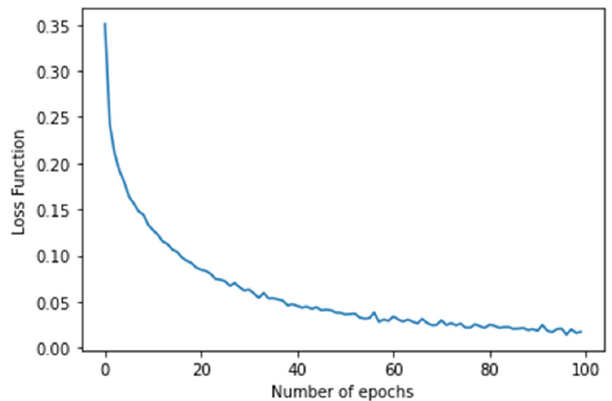
Figure 6. Confusion matrix generated by the proposed image ‐ encoding ‐ based deep neural network for the WESAD dataset where the percentage of data are being displayed in each quadrant.